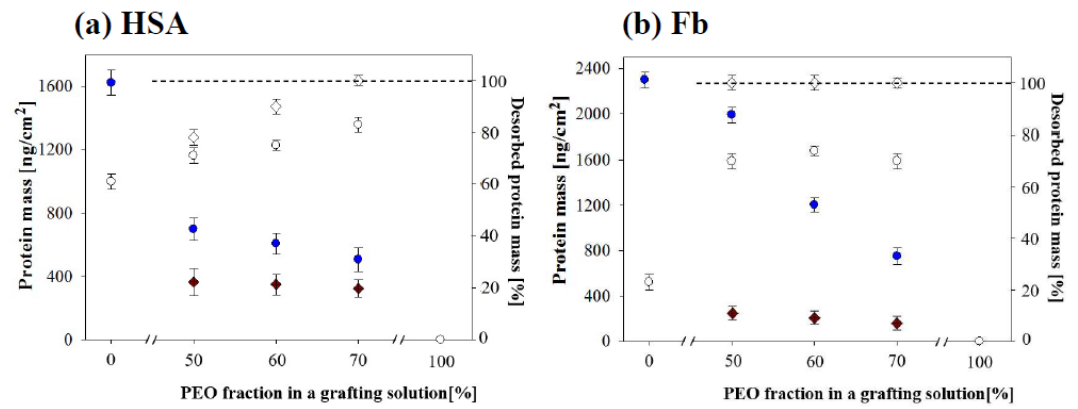
Figure 6. Dependence of protein mass obtained from the Sauerbrey modeling of ∆ f recorded by QCM-D after the adsorption step (left axis, R2, I = 10 − 3 M, pH 7.4) and a percentage of remaining protein mass after the desorption step (right axis, R4 I = 0.15 M, pH 9.0) as a function of PEO fraction (%) in the grafting solution (PEO1-circles, PEO5-diamonds, closed symbols - protein mass after adsorption, open symbols–protein mass after desorption): ( a ) HSA, ( b ) Fb.